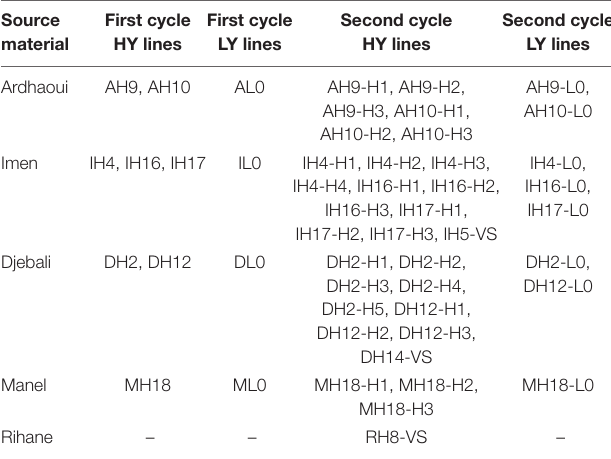
The coding of lines is based on two letters and the number of the selected plant. In the case of the bulk sample, this is indicated with 0. The first letter indicates the source material from which the line has been selected (A stands for Ardhaoui, I for Imen, D for Djebali, M for Manel, and R for Rihane). The second letter indicates whether the selection is based on high yield (H) or low yield (L). Cases indicated with VS, stand for visual